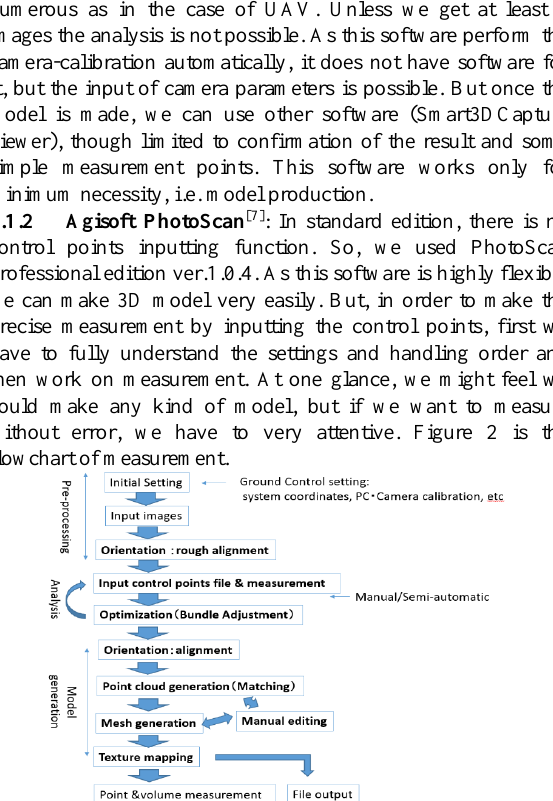
Figure 2. Measuring flowchart of PhotoScan